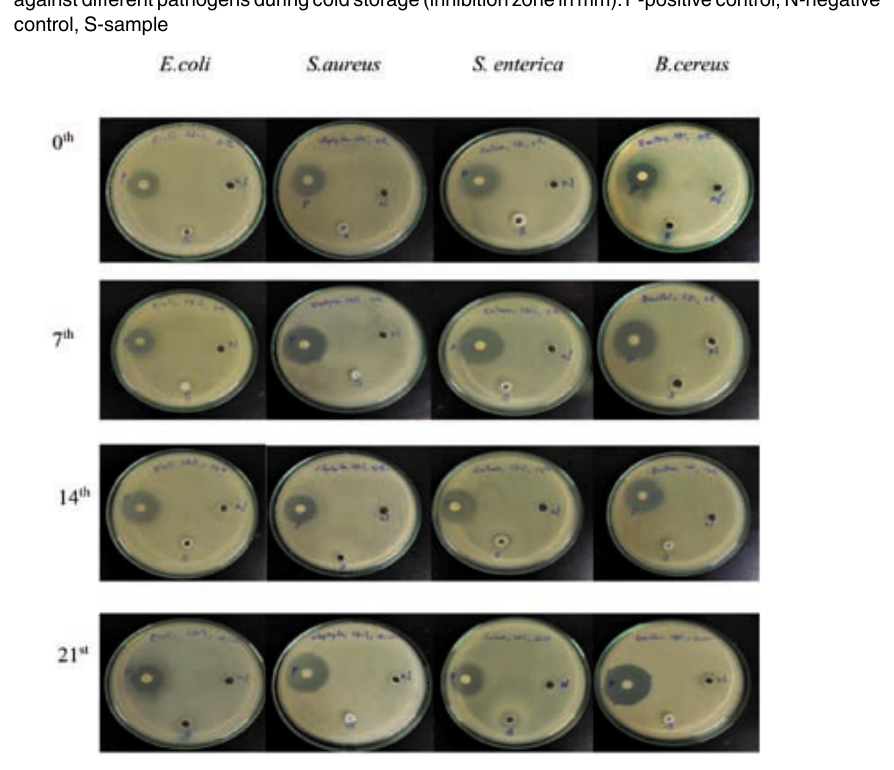
Fig.4. Antibacterial activity of the WSPE of fermented milk made from goat milk heated to 121°c/15sec against different pathogens during cold storage (inhibition zone in mm). P-positive control, N-negative control,